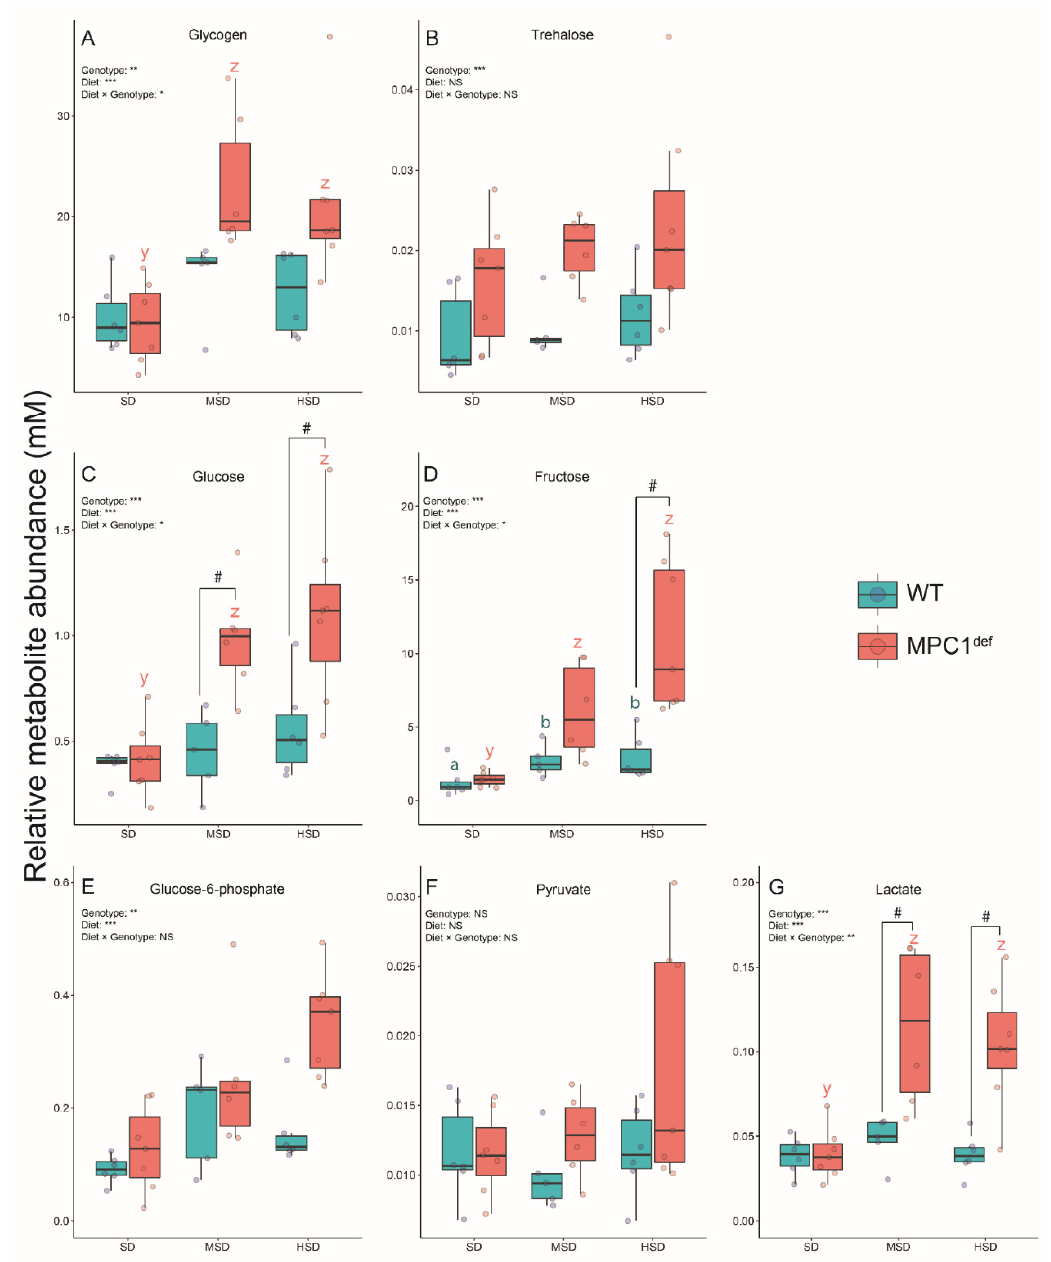
Figure 4. Sugar and glycolysis intermediate levels measured in Drosophila melanogaster WT and MPC1 def exposed to the di ff erent experimental diets (SD, MSD, or HSD): ( A ) glycogen levels, ( B ) trehalose levels, ( C ) glucose levels, ( D ) fructose levels, ( E ) glucose-6-phosphate levels, ( F ) pyruvate levels, and ( G ) lactate levels. Results correspond to the mean ± SEM for each condition (N = 6–7). Statistical analysis: stars represent statistical results from ANOVAs with * p < 0.05, ** p < 0.01, and *** p < 0.001; # represents significant di ff erences between genotypes for each experimental diet detected using the estimated marginal means method; and letters denote di ff erences between experimental diets for each genotype, with “a” and “b” representing di ff erences between the WT flies and “y” and “z” representing di ff erences between the MPC1 def flies.